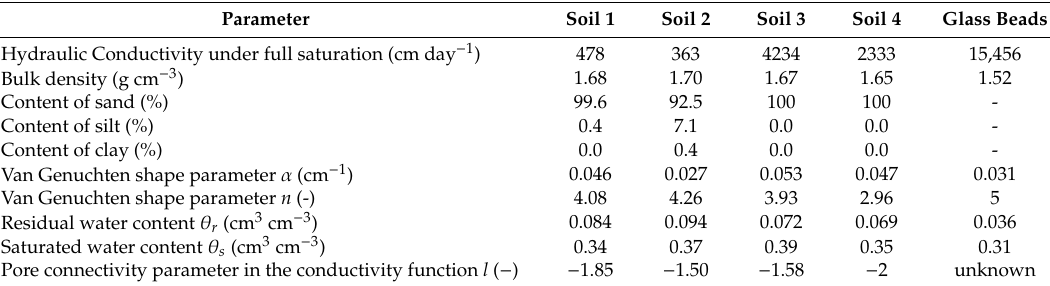
Table 1. Initial parameters obtained from the permeameter test [22]; bulk density estimated by [24] and retention behavior laboratory test [23].